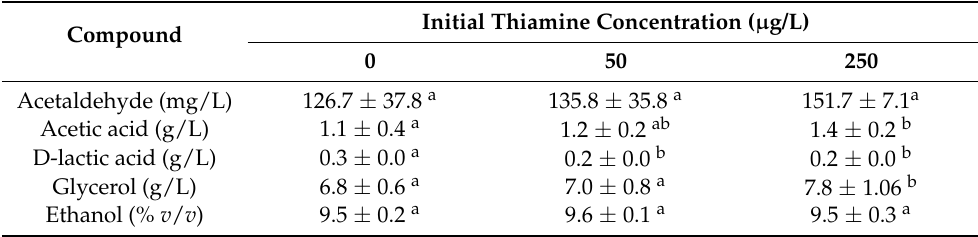
Table 5. Central carbon metabolites in the final wines produced in varying initial thiamine concentra-